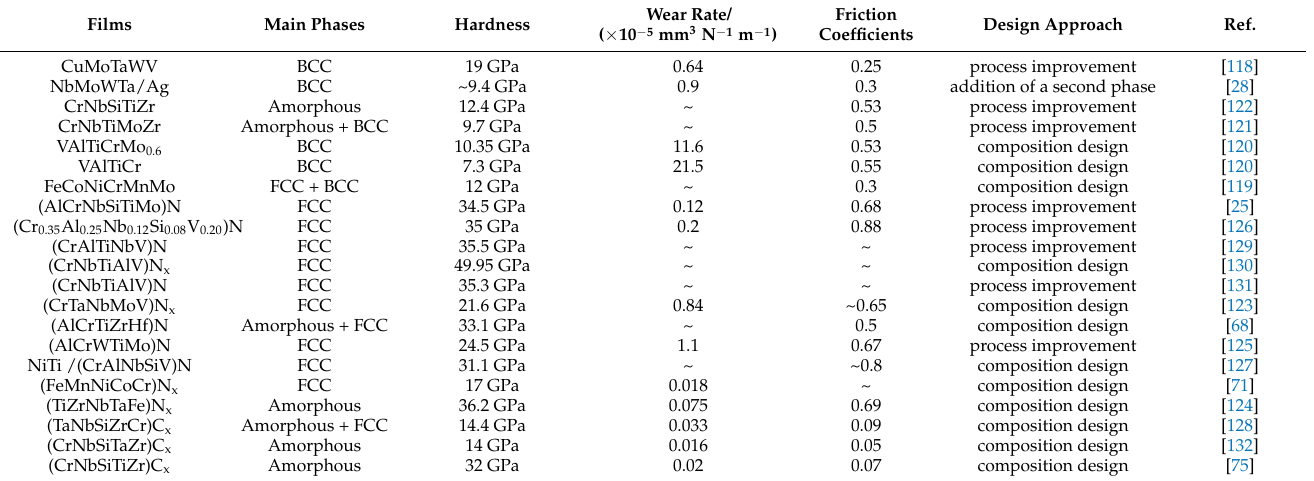
Table 4. The microstructure and tribological properties of HEA films prepared by magnetron